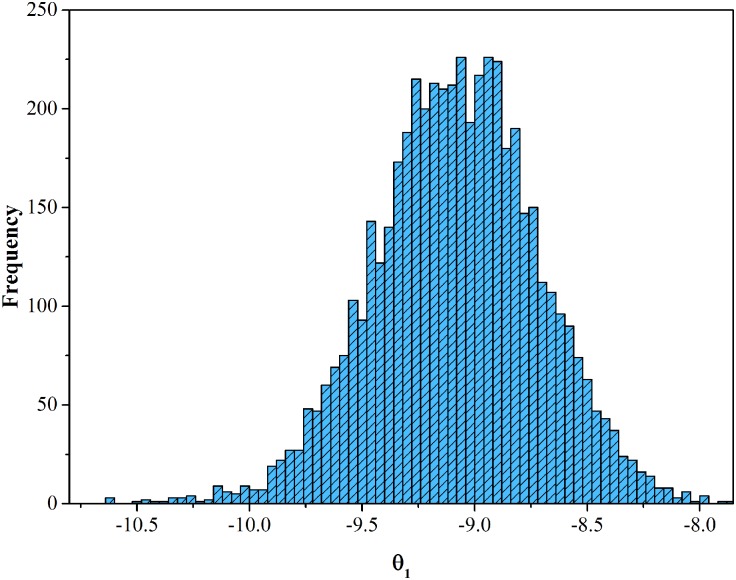
The distribution of effective samples for θ1.The figure exhibits the frequency distribution of the samples to represent the convergence directly.